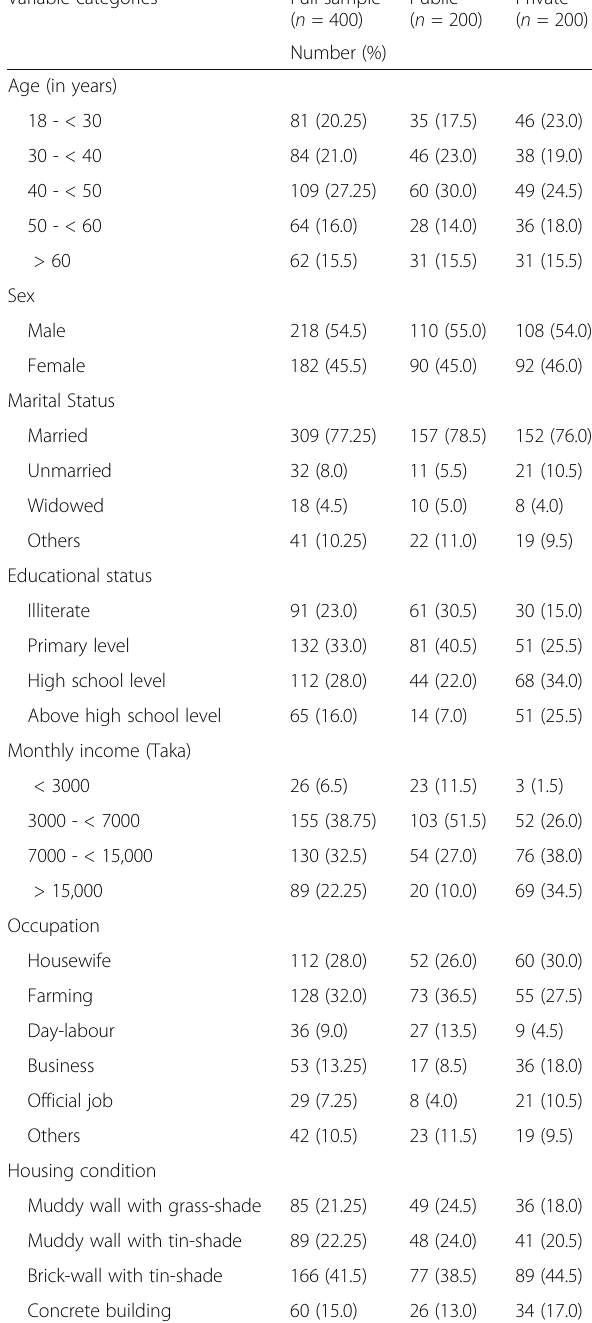
Table 1 Cronbach ’ s Alpha of the variables of PSSQ and ESSQ domains